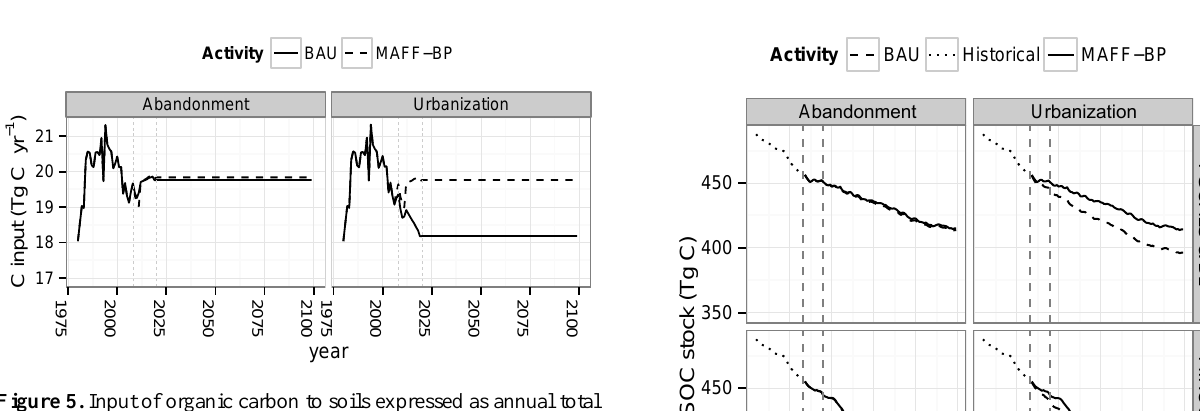
Figure 5. Input of organic carbon to soils expressed as annual total sum for all land-use types under different scenarios of future land- use change (abandonment and urbanization; lined-up horizontally) in periods including historical (1970–2006), future scenarios during 2007–2020 with varying input rate toward target or predicted levels in 2020, and subsequent future period in 2021–2099 with assuming no change in input rate after 2020. Solid and dashed line indicate fu- ture agricultural activity scenario BAU and MAFF-BP, respectively.